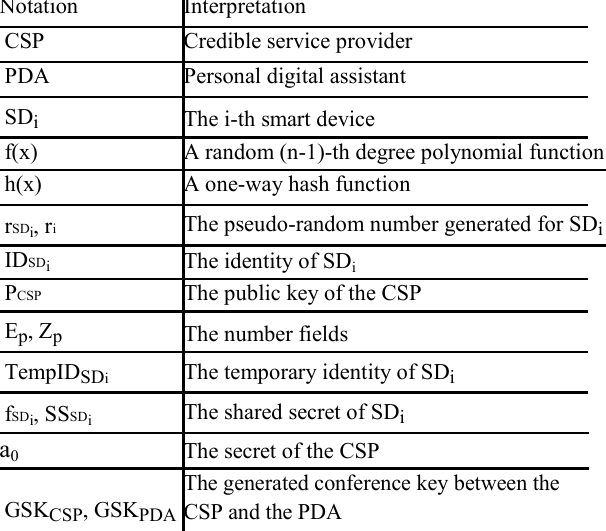
Table 1. Notation used in the group devices authentication